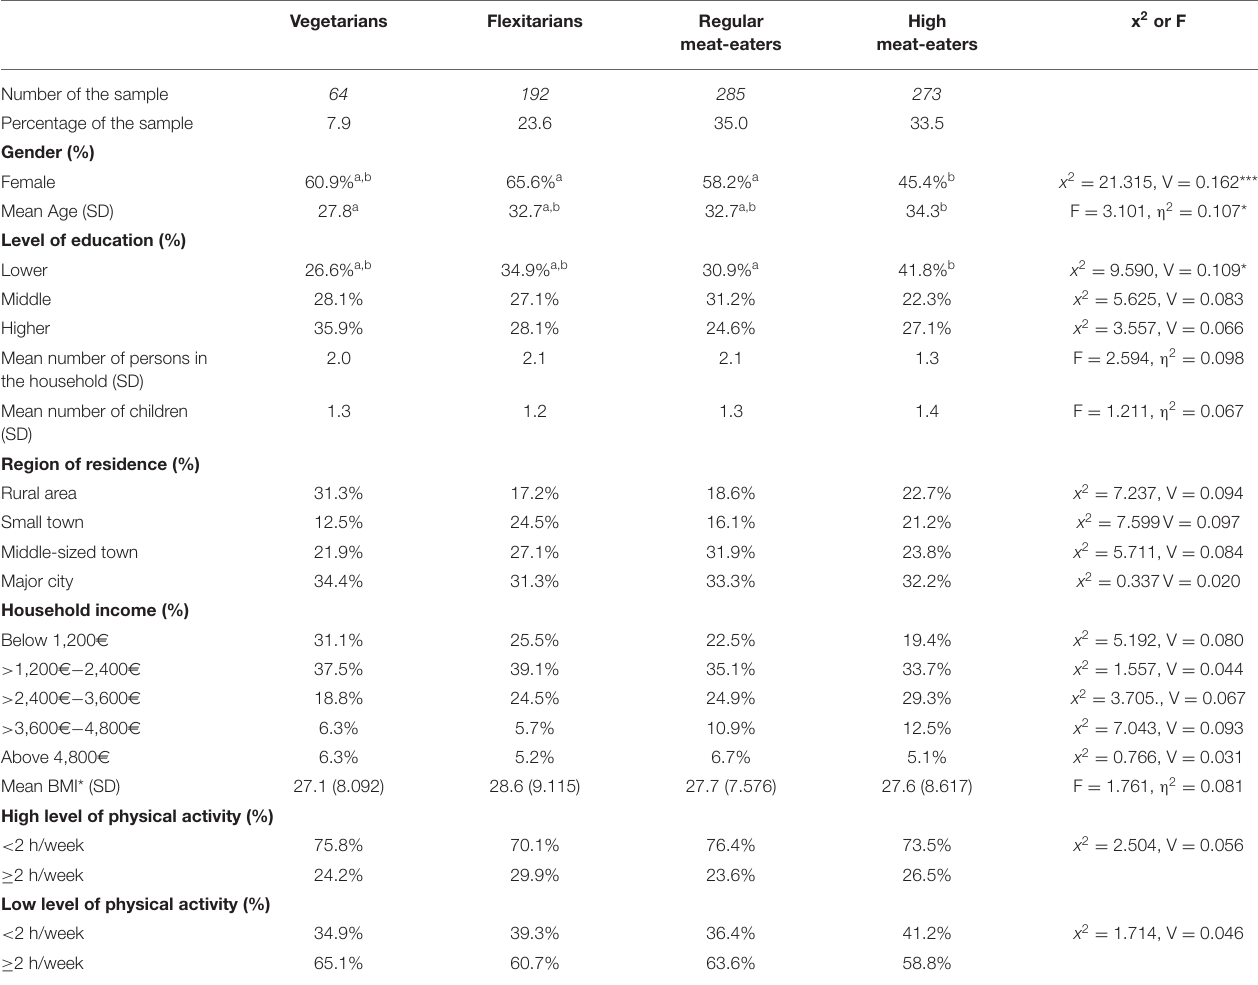
TABLE 3 | Characteristics according to dietary groups [vegetarians (no meat), flexitarians ( ≤ 1 × meat/week), regular eat-eaters ( ≤ 7 × meat/week), high meat-eaters ( > 1 × meat/ day)]. Vegetarians Flexitarians Regular High meat-eaters